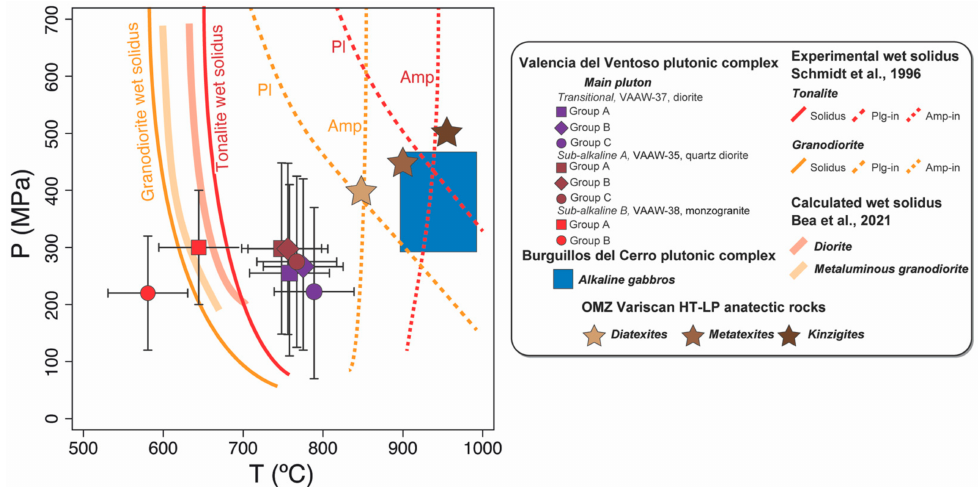
Figure 6. Average P-T estimates in intermediate and border facies rocks from the Valencia del Ventoso main pluton using amphibole-plagioclase thermobarometry and Al-in-hornblende barometry. P-T estimates for Variscan alkaline gabbros and anatectic metasediments from the OMZ also shown (after [3]). Wet solidus and plagioclase-in and amphibole-in reactions in synthetic tonalite and granodiorite systems as experimentally established by [56], and wet solidus for metaluminous granodiorite and diorite as calculated by [57] using rhyolite-MELTS [58].